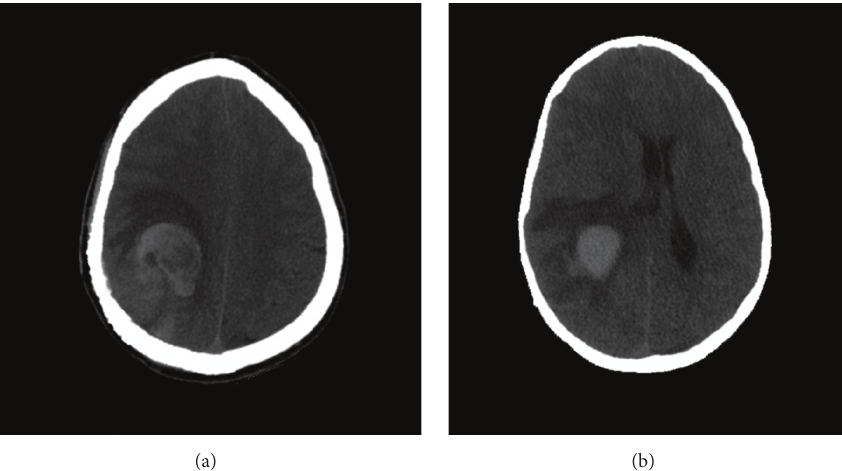
Figure 1: Axial CT of head for patient demonstrates right parietal heterogeneous, hyperdense mass with a large medial hematoma.